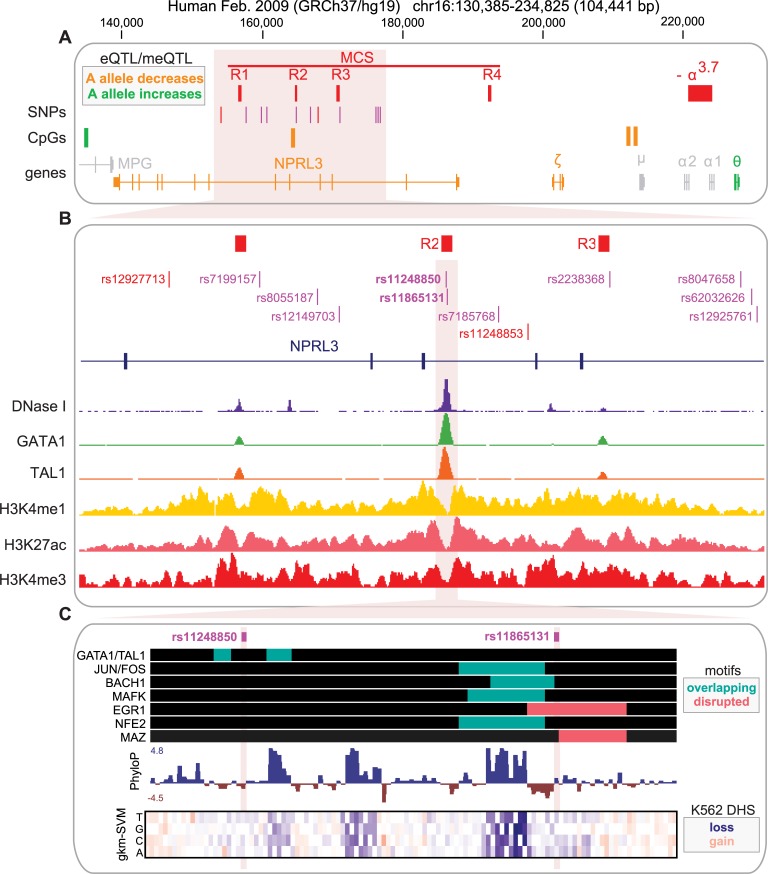
Genomic context of the α-globin regulatory GWAS locus.(A-B) The genomic region spanning the NPRL3 and HBA1 genes that contain the lead variant rs11248850 and its LD proxies, multi-species conserved sequences (MCS R1-4), and the -α3.7 deletion. eQTL(48, 49) and meQT(50) results from blood samples that reach genome-wide significance are shown, as well as the effect direction corresponding to the A alleles of rs11248850 and rs11865131. Although not illustrated, decreased expression of SNRNP2 was also associated in cis with the A allele. (B) rs11248850 and its LD proxies (magenta color indicates R2 ≥ 0.9 and red indicates R2 ≥ 0.8 but < 0.9). Signal tracks of DNaseI hypersensitivity(32), ChIP-seq for the key erythroid transcription factors GATA1 and TAL1(34), and histone modifications H3K4me1, H3K27ac and H3K4me3(33) from human derived erythroblasts are shown. The MCS-R2 enhancer element which overlaps rs11248850 and rs11865131 is highlighted in pink. (C) ChIP-seq occupancy sites are shown for transcription factors that were profiled in K562 cells and have motifs proximal to either of the MCS-R2 variants(43, 44). Evolutionary conservation across 100 vertebrates (PhyloP score)(47) and in silico mutagenesis(42) using a gkm-SVM trained on K562 DNase I hypersensitivity data identify likely functional motifs in the MCS-R2 element. Although rs11248850 appears to disrupt a GATA1 motif, it is not predicted by our software to have an effect as it resides in the low information content section between the GATA1 core and TAL1 core motifs.